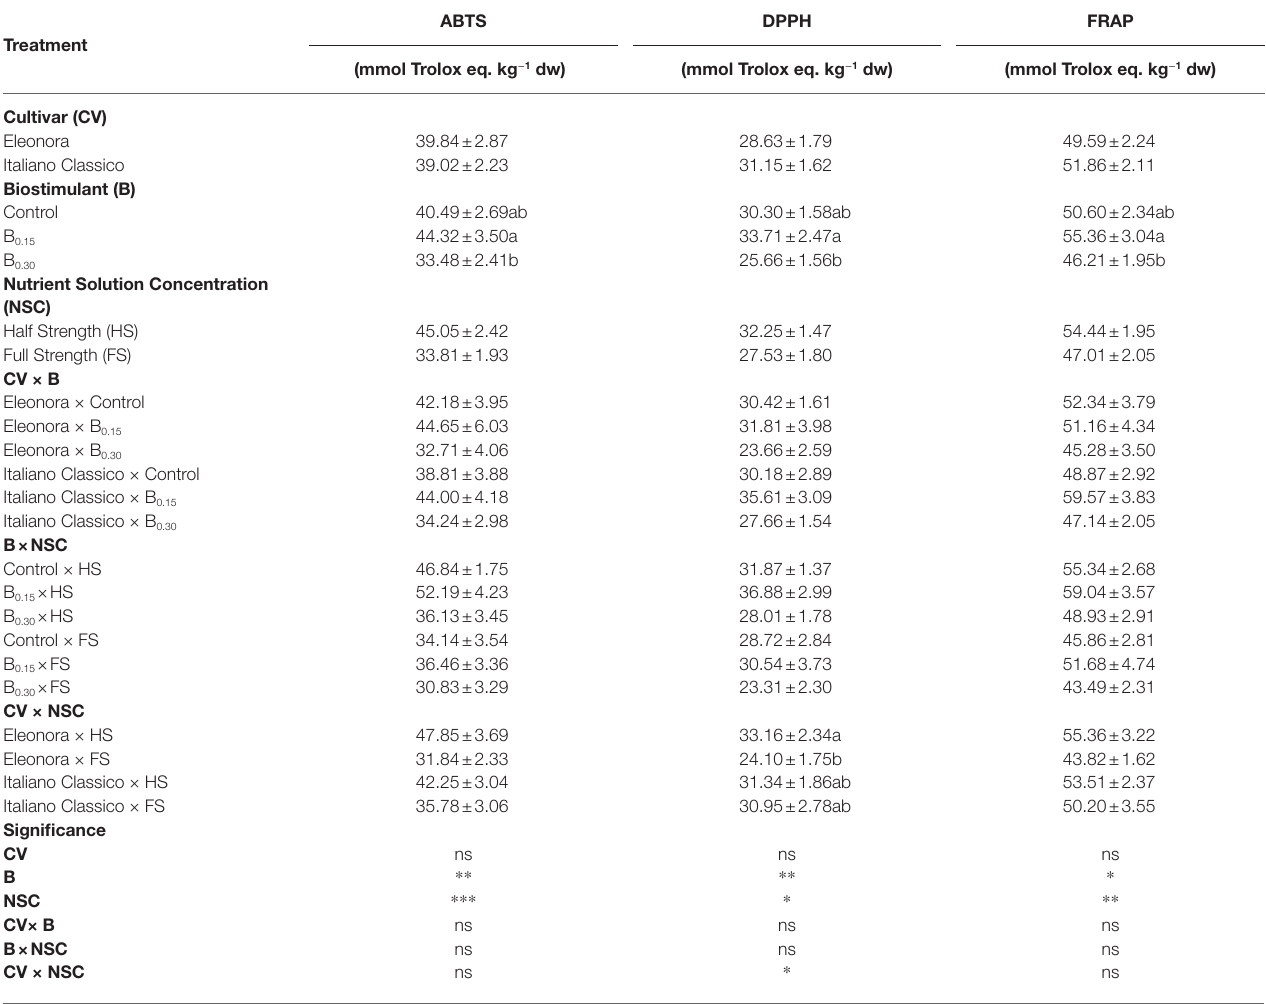
TABLE 4 | Analysis of variance and mean comparisons for ABTS, DPPH, and FRAP antioxidant activities of Eleonora and Italiano Classico genotypes grown hydroponically under two nutrient solution and dose of biostimulant.